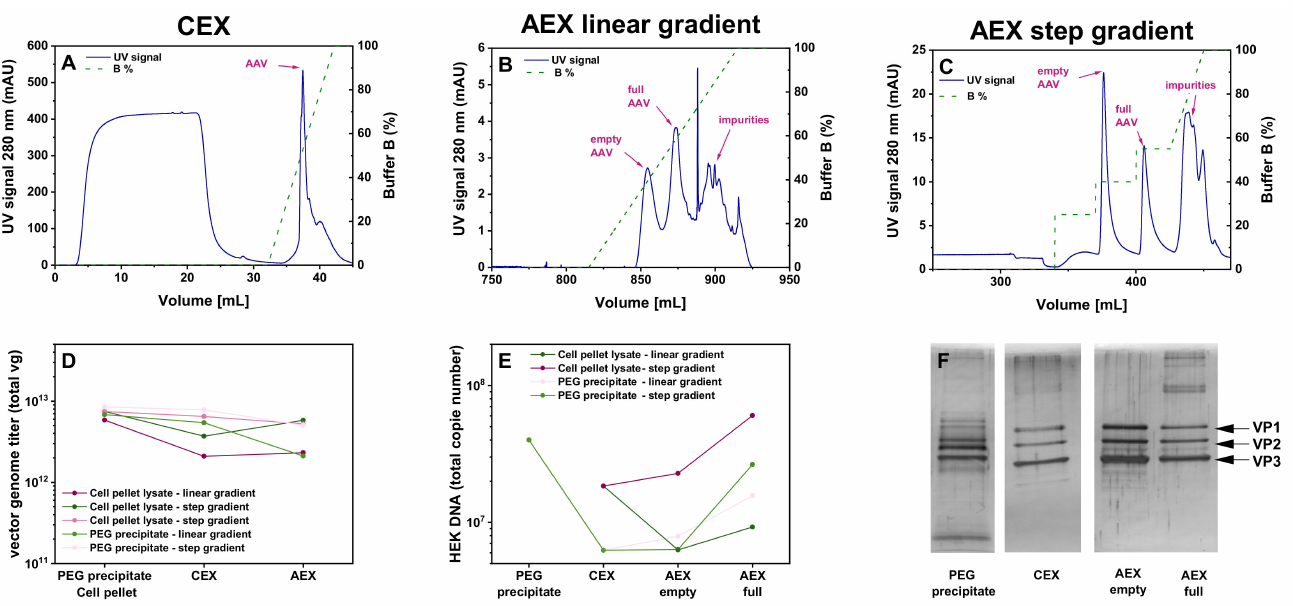
Figure 5. Purification of the rAAV2/8 vectors using CEX-AEX(E/F). ( A – C ) Chromatograms obtained with a PEG- precipitated material and a CEX-AEX(E/F) process in only two steps on a CEX ( A ) and a novel CIMmultus PrimaS (AAV) ( B , C ) column. ( A ) CEX with a linear buffer B gradient. ( B ) CIMmultus PrimaS (AAV) with a linear buffer B gradient. ( C ) CIMmultus PrimaS (AAV) with a step gradient of 25%, 40%, and 55% buffer B. Each chromatogram shows the respective UV signal in blue (scale on the left Y -axis) and the concentration of buffer B depicted as a dashed green line (scale on the right). ( D ) Graph showing the yield (total vector genomes, vg) for the rAAV2/8 vectors obtained in the CEX- AEX(E/F) downstream process with material harvested by PEG precipitation ( n = 2) from the cell culture supernatant and cell pellet lysate ( n = 3). ( E ) Residual human embryonic kidney (HEK) cell DNA amount determined by real-time quantitative polymerase chain reaction (qPCR). ( F ) Silver-stained sodium dodecyl sulfate polyacrylamide gel electrophoresis (SDS-PAGE) of the material from each step of the purification CEX-AEX(E/F) downstream process. AEX, anion exchange chromatography; CEX, cation exchange chromatography; PEG, polyethylene glycol; rAAV, recombinant adeno-associated virus; TFF, tangential flow filtration; VP, viral protein. Table 2. Amount of empty capsids in the fractions containing full rAAVs determined by analytical AEX. Residual Amount of Empty Capsids Number of in Full rAAV Fractions (%) Purification Strategy Preparations Entire